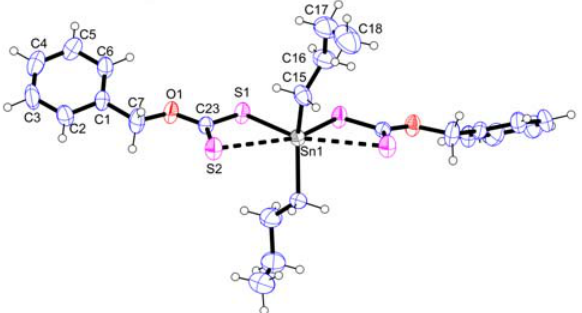
] Sn(S COCH C H ) 2 2 2 6 5 2